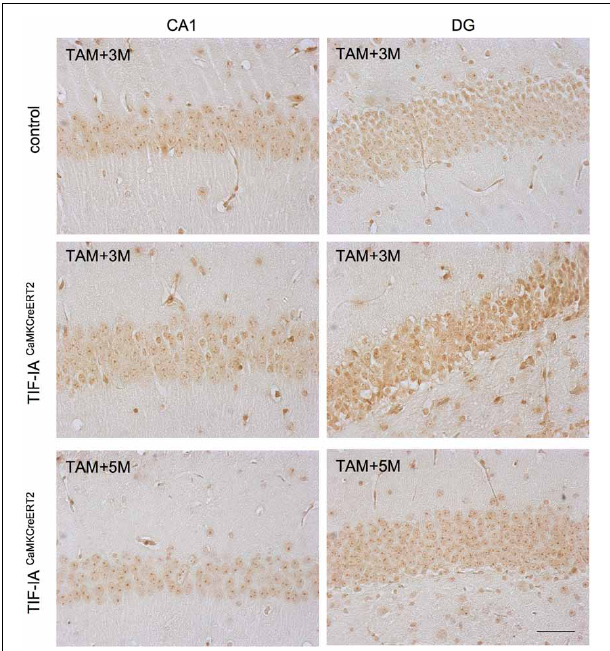
FIGURE 5 | pre-rRNA is restored in CA1 and DG of TIF-IA CaMKCreERT2 mutants. Representative images of in situ hybridization performed in control and TIF-IA CaMKCreERT2 mutant mice 3 and 5 months after tamoxifen. Three months after tamoxifen TIF-IA CaMKCreERT2 mutant mice show loss of pre-rRNA in CA1 and DG in comparison to controls. Five months after tamoxifen TIF-IA CaMKCreERT2 show intense pre-rRNA staining in the nucleoli. The sections were slightly counterstained with nuclear fast red. Scale bar: 60 μ